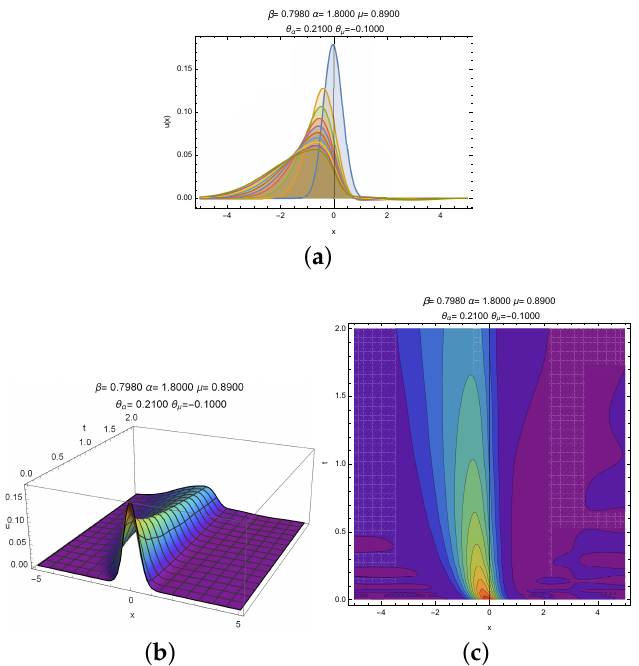
Figure 3. ( a ) Approximation of fFP for different times ( t ∈ { 0.1,0.3,0.5,0.7,0.9,1.1,1.3,1.5,1.7,1.9 } , top down) using a normalized Gaussian with amplitude b = 4; ( b ) 3D graph of the approximation; and ( c ) contour plot of the approximation. The fractional exponent are given on top of the graphs.